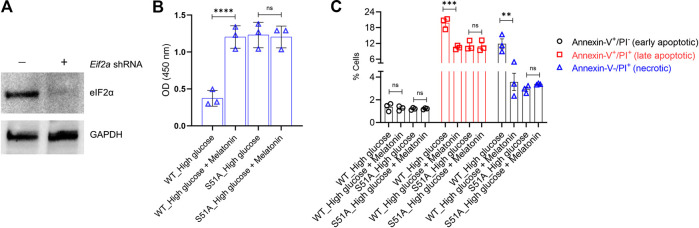
PERK-eIF2α-ATF4 axis is crucial for the protective action of melatonin (A) MC3T3-E1 cells were transduced with shRNA targeting the 3′-UTR of Eif2a. Successful knockdown was verified by immunoblotting. The representative blots from three independent experiments are shown. GAPDH was used as a loading control. (B,C) MC3T3-E1 cells in which endogenous Eif2a was stably knocked down were stably transfected with an Eif2a-S51A phospho-dead mutant expression constructed. MC3T3-E1 and MC3T3-E1/S51A cells were then grown under high glucose ± melatonin for 24 h (B) Cell proliferation was determined by the CCK8 assay and (C) apoptotic cell death was determined by Annexin-V/PI staining. For (B,C), bars are mean ± SEM. **p < 0.01, ***p < 0.001, ****p < 0.0001, ns: not significant.